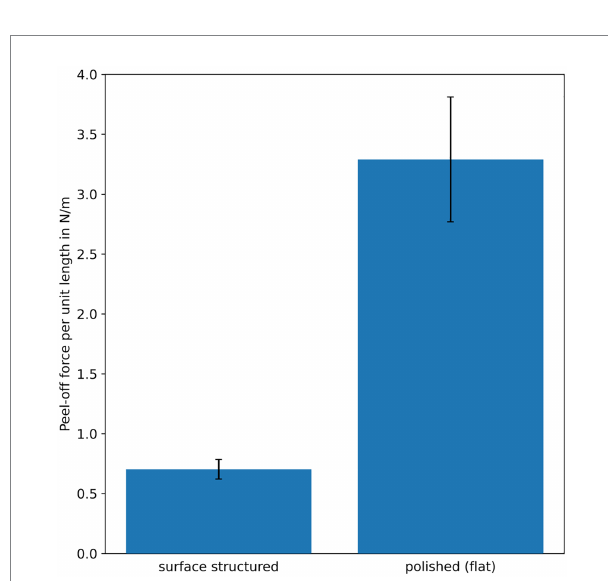
FIGURE 7 Results of the peel-off force per unit length measurements from Table 1 (mean values) visualized as bar plot. The error bars denote the standard deviations. The peel-off force per unit length is significant lower for the samples with the triangular surface structure, than for the polished (flat) control samples.